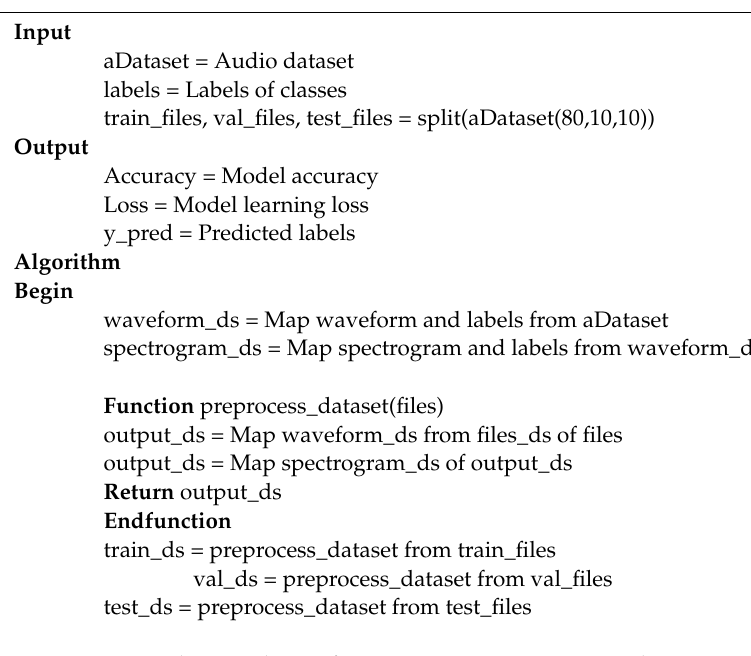
Algorithm 1: Steps of classification of Arabic short vowels on a fully optimized and fine-tuned neural